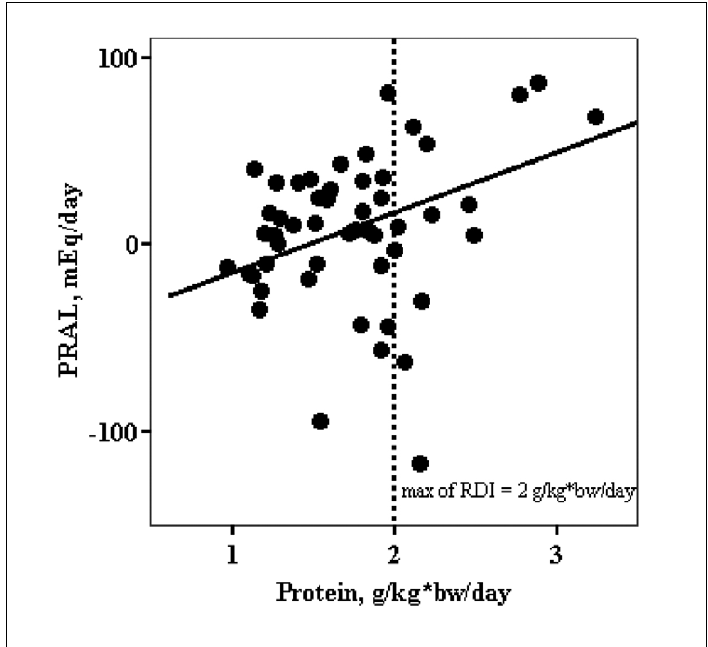
Figure. Relationship between PRAL (mEq/day) and dietary protein intake (g/kg body weight/day)